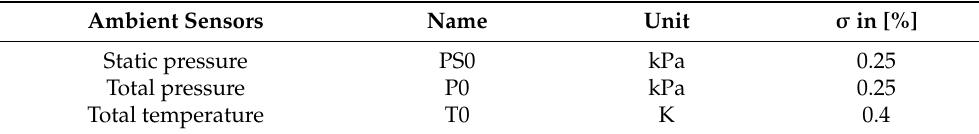
Table 1. Ambient sensors.